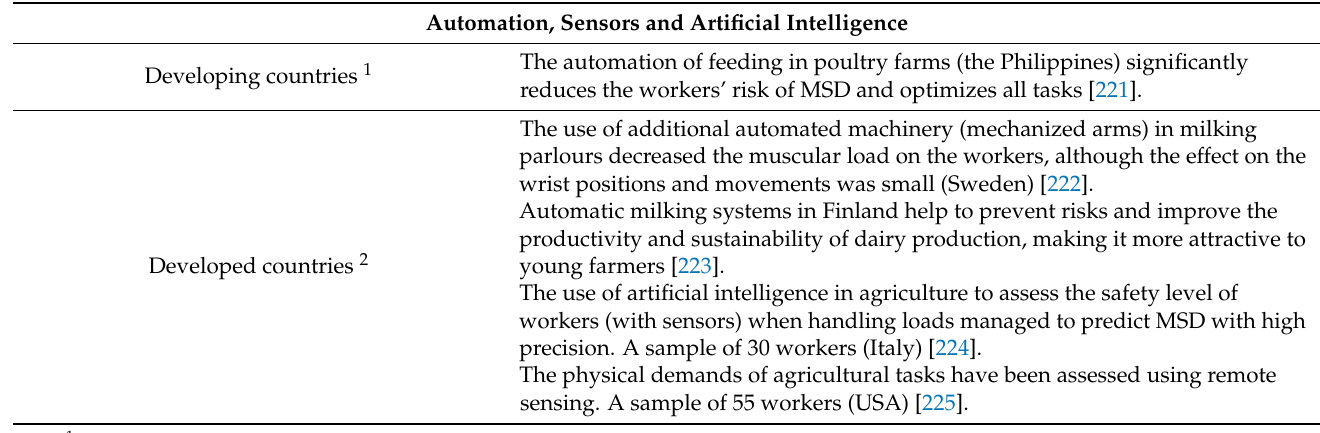
Table A19. MSD research in agriculture (1995–2020). Category: Automation, sensors and artificial intelligence. Automation, Sensors and Artificial Intelligence Developing countries